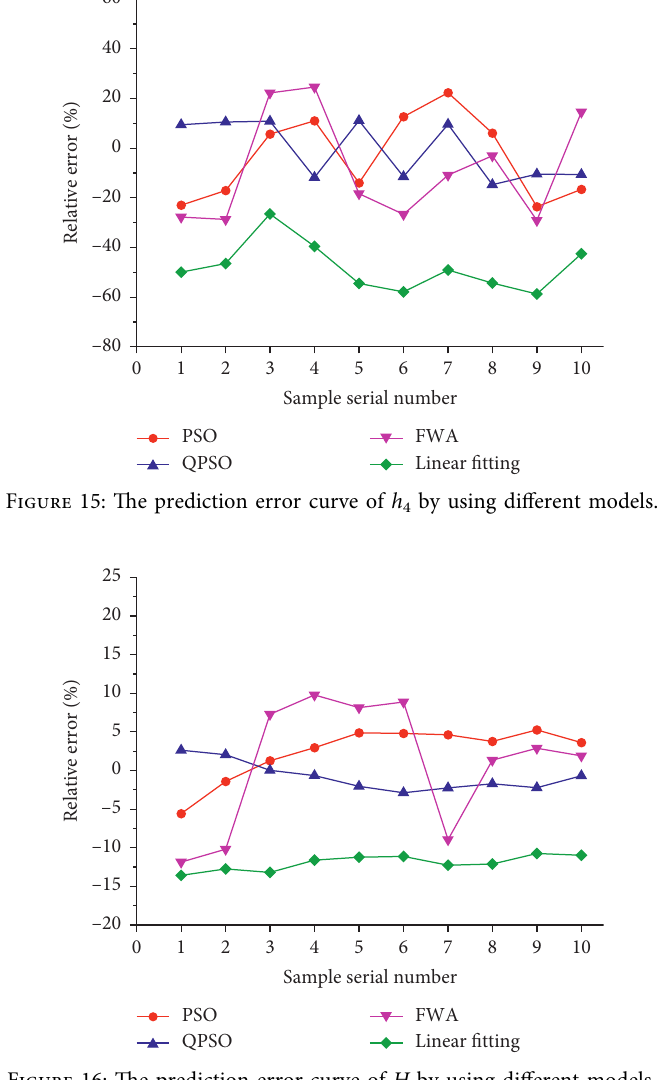
Figure 16: The prediction error curve of H by using different models.